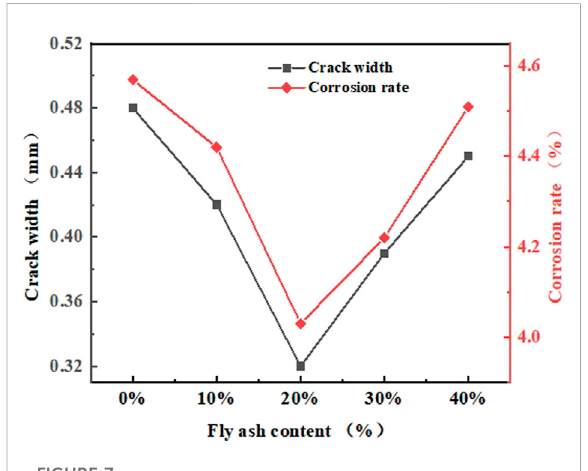
FIGURE 7 Corrosion rate and crack width with fl y ash